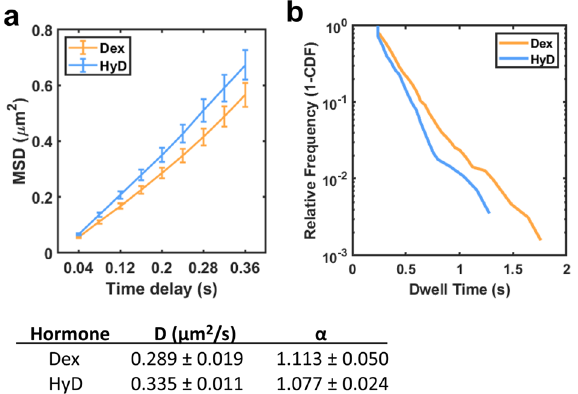
Figure 1. Dynamic properties of HaloTag-GR as measured by MFM. ( a ) Mean squared displacement (MSD) curves for HaloTag-GR treated with either 100 nM dexamethasone (Dex) or 100 nM hydrocortisone (HyD) for 30 min. Below, the calculated diffusion coefficients and α factors for each curve. ( b ) Dwell time analysis for HaloTag-GR treated with either 100 nM dexamethasone or 100 nM hydrocortisone. For both ( a ) and ( b ), a total of 236 and 151 trajectories were analyzed for dexamethasone and hydrocortisone treatment, respectively.